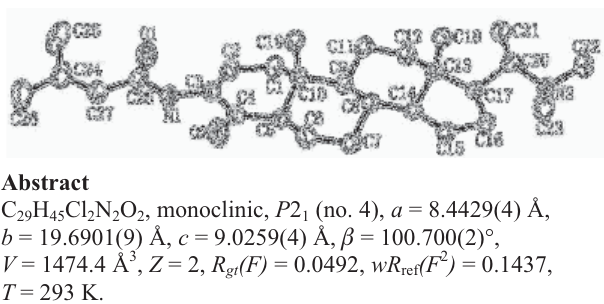
Table 1. Data collection and handling.